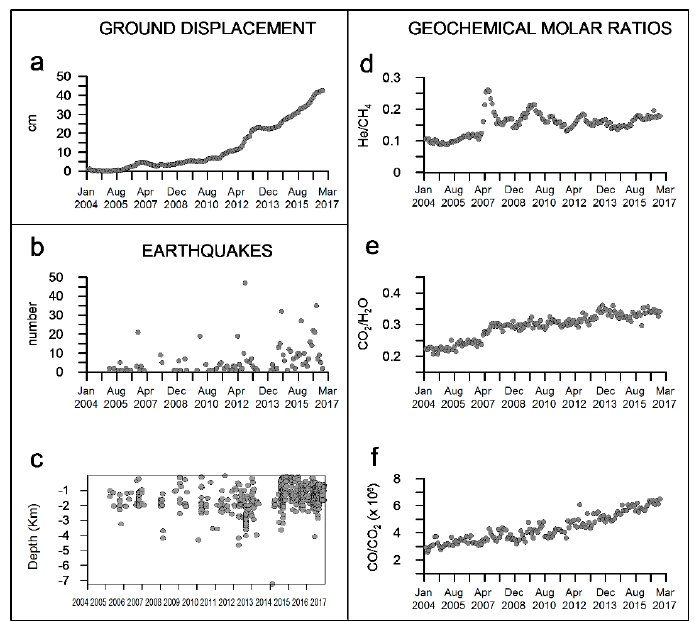
Figure 2. Time variation of ( a ) ground displacement, ( b ) earthquakes number, ( c ) earthquakes hypocentral depths, ( d ) He/CH 4 molar ratio, ( e ) CO 2 /H 2 O molar ratio, ( f ) CO/CO 2 molar ratio.